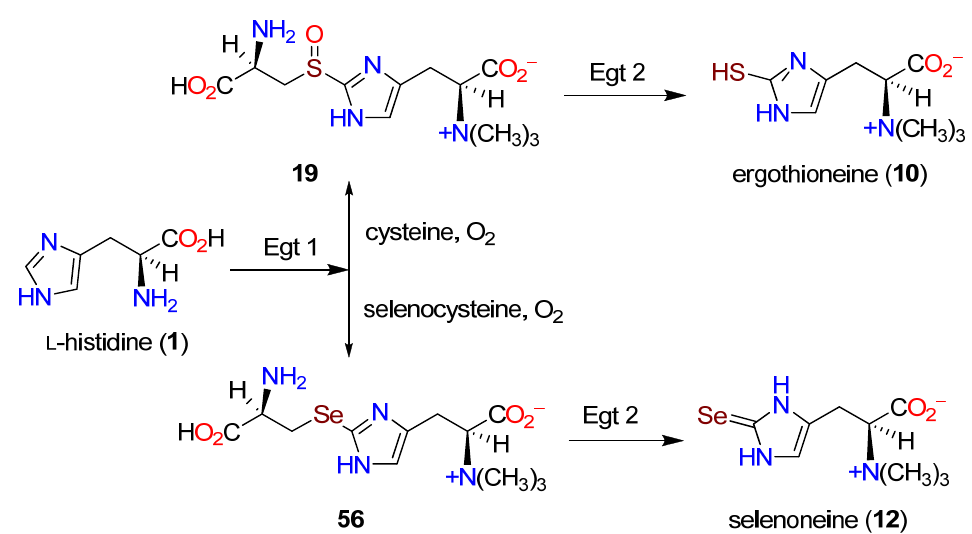
Figure 19. Divergent biosynthetic pathways from histidine ( 1 ) to ergothioneine ( 10 ) and selenoneine ( 12 ) through 19 and 56 (adapted from ref. 100).